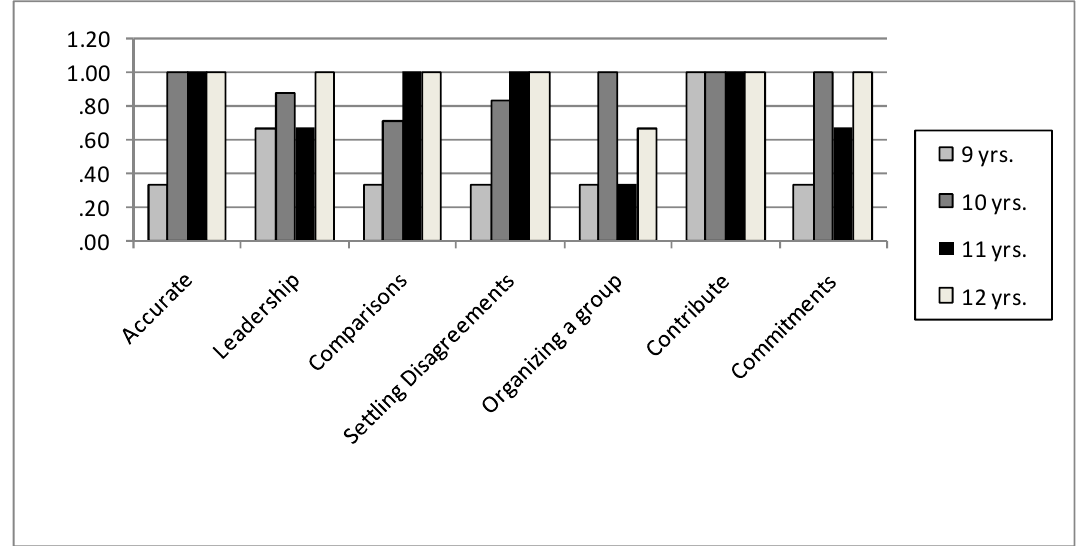
The participants’ level of understanding of major life skill concepts deliniated by